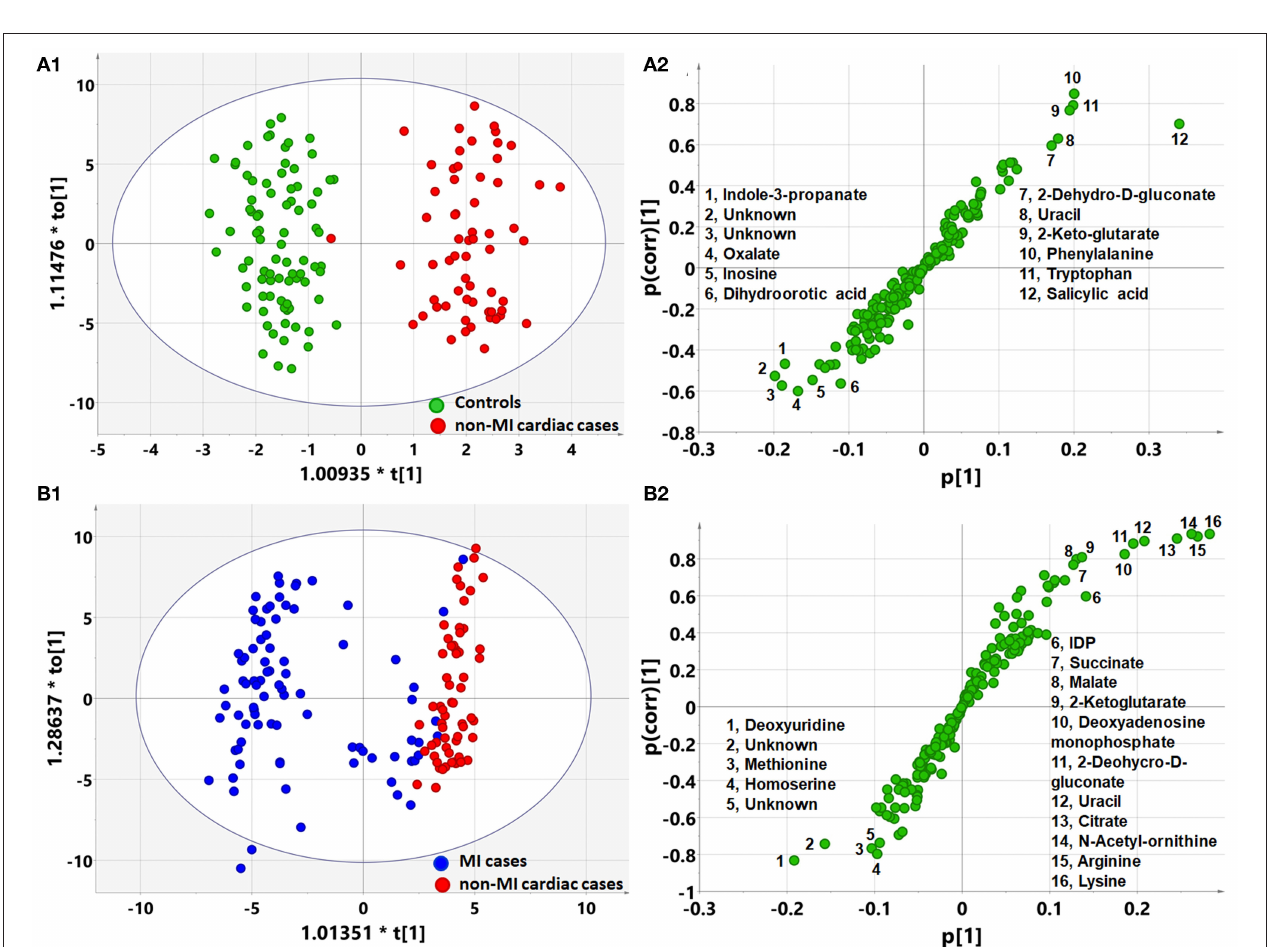
FIGURE 2 | Orthogonal partial least square to latent structure discriminant analysis (OPLS-DA) modeling and S-plots delineate different metabolic phenotypes and potential markers of MI and non-MI cardiac cases. (A1) OPLS-DA model differentiating non-MI cardiac cases ( n = 61) from the controls ( n = 84). (A2) S-plot highlights the potential markers of the non-MI cardiac cases. (B1) OPLS-DA model differentiating MI cases ( n = 85) from non-MI cardiac cases ( n = 61). (B2) S-plot highlights the potential markers of the MI